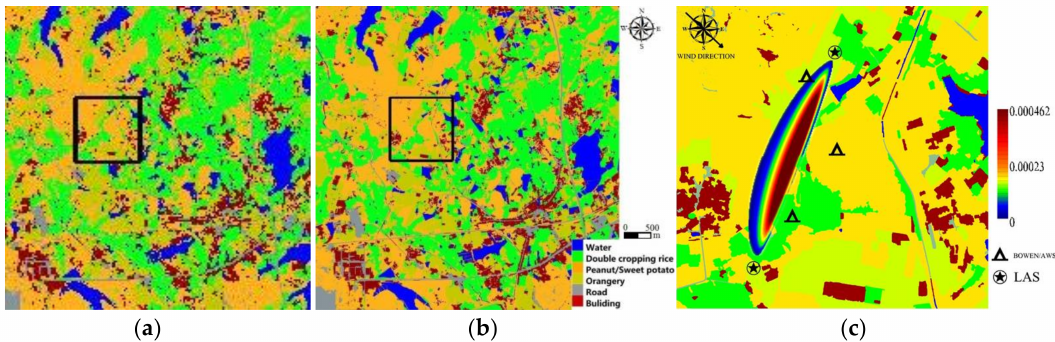
Figure 1. Map of the land cover types and instrument locations. ( a ) Land cover type (30 m resolution form Landsat8); ( b ) Land Cover Type (0.5 m resolution form Pleiades); ( c ) The large aperture scintillometer (LAS) source areas (90% flux contribution) and instrument locations, identical to the areas in the black boxes on ( a , b